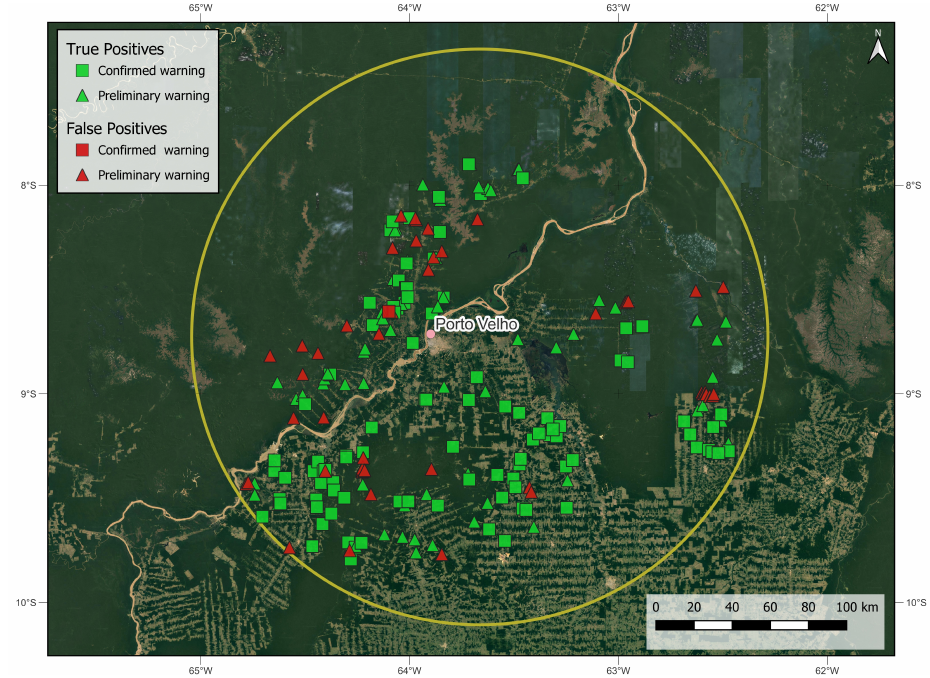
Figure 8. Detailed map of the field validation results. The outer yellow circumference corresponds to the limits of the monitored special